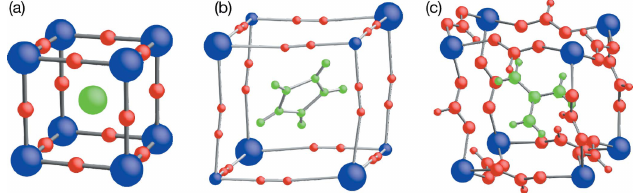
Figure 1 The A (green), B (blue), and X (red) sites in conventional and hybrid perovskites, showing the larger A -site ions possible as the length of the X - site linker increases: ( a ) monatomic X and A (Goldschmidt, 1927); ( b ) diatomic X = cyanide, A = imidazolium (Zhang et al. , 2010); ( c ) triatomic X = formate, A = guanidinium (Hu et al. , 2009).